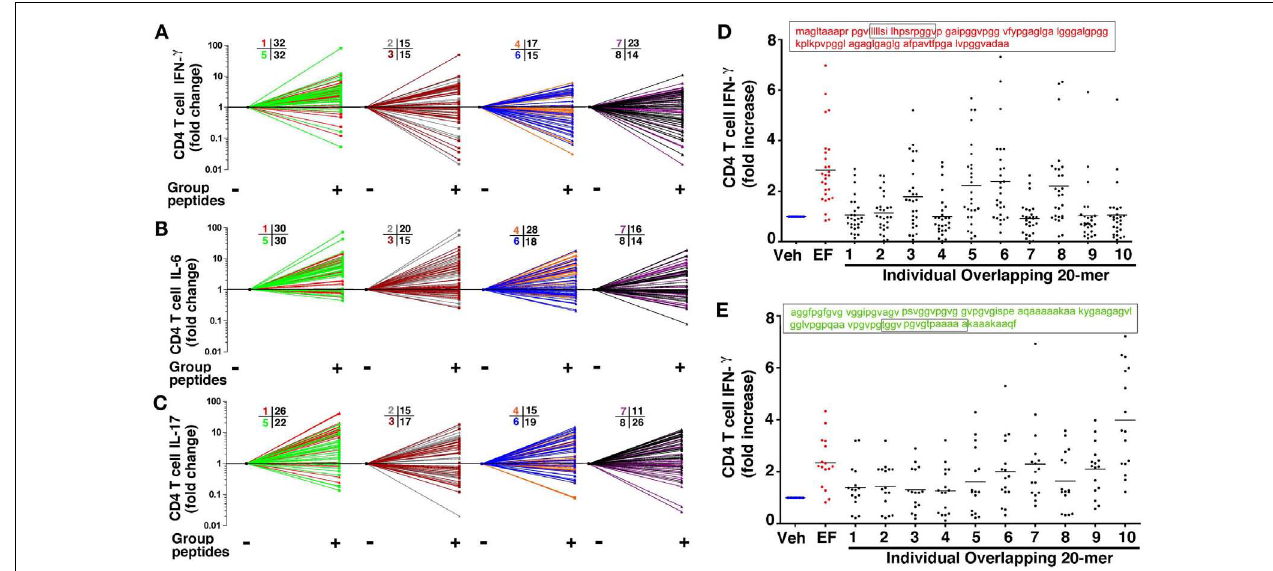
per spray plot; n = 39.The numbers corresponding to each color indicate the numbers of individuals with a positive ( > 1.5-fold increase) response over nil stimulation. Using the sameT cell/APC assay, IFN- γ fold increase induced by each 20-mer (1–10) within (D) group 1 (shown in red) and (E) group 5 (shown in green) were plotted as fold increase relative to nil stimulation; each dot represent one volunteer; n = 27 for group 1, n = 16 for group 5. Lung elastin fragments (EFs; 30 µ g/ml) were used as positive control.Veh, vehicle